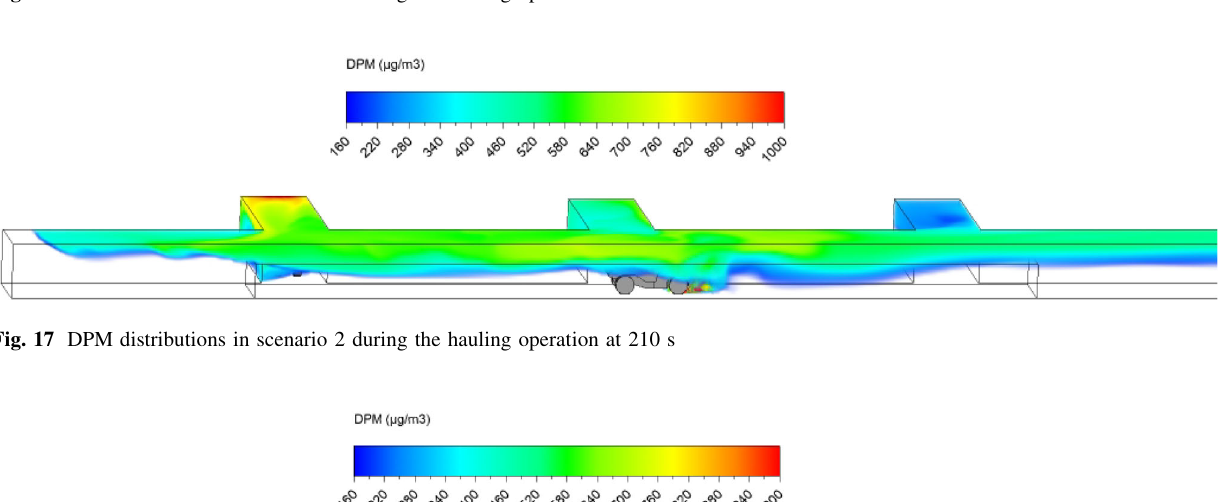
Fig. 16 DPM distributions in scenario 2 during the hauling operation at 195 s